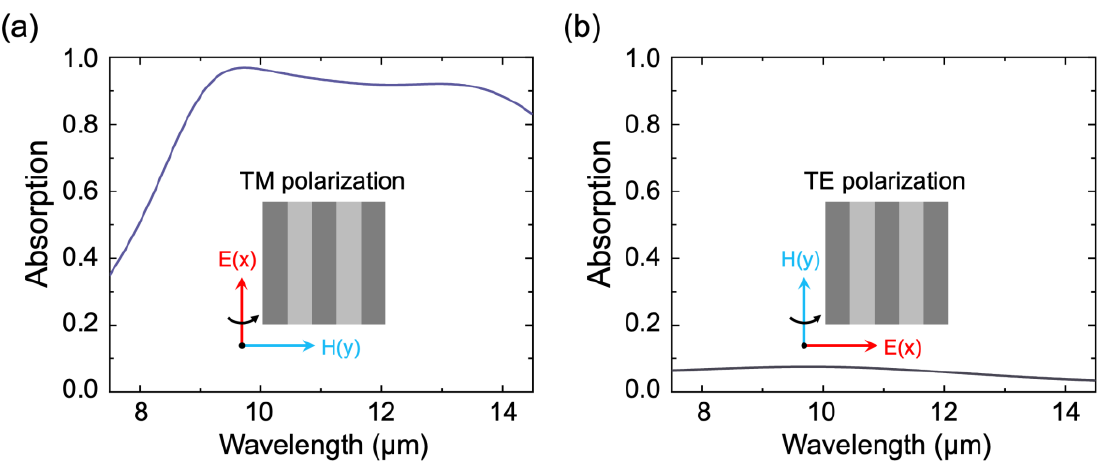
Figure 6. Simulated absorption spectrum of designed high-performance metamaterial absorber under ( a ) TM- and ( b ) TE-polarized light.